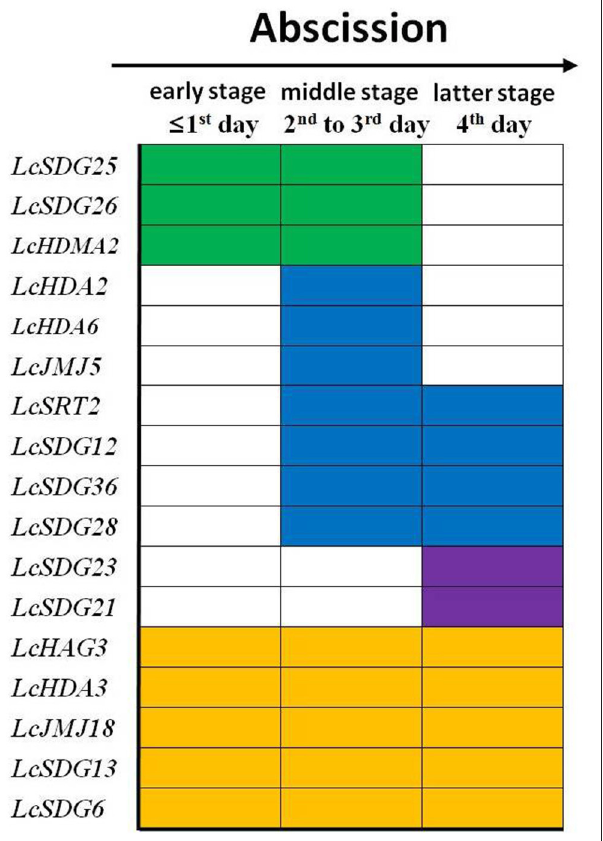
FIGURE 9 | Patterns of differently expressed HMs in response to fruit abscission in litchi. The early stage responsive genes were shaded in green (from 1st to 3rd day); the middle stage responsive genes were shaded in blue (from 2nd to 3rd or to 4th day); the latter stage responsive genes were shaded in purple (4th day); the full stage responsive genes were shaded in yellow (from 1st to 4th day).